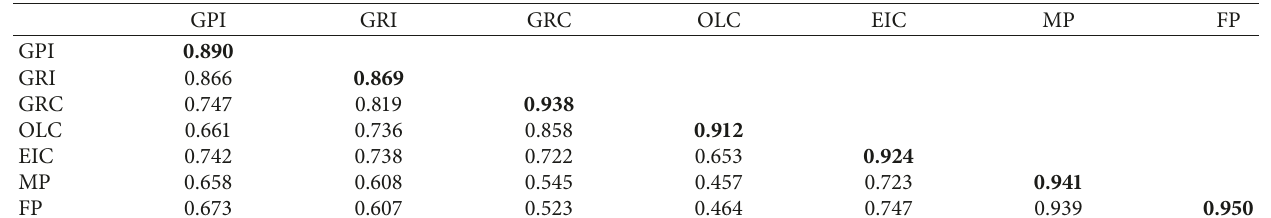
Table 9: Result of discriminant